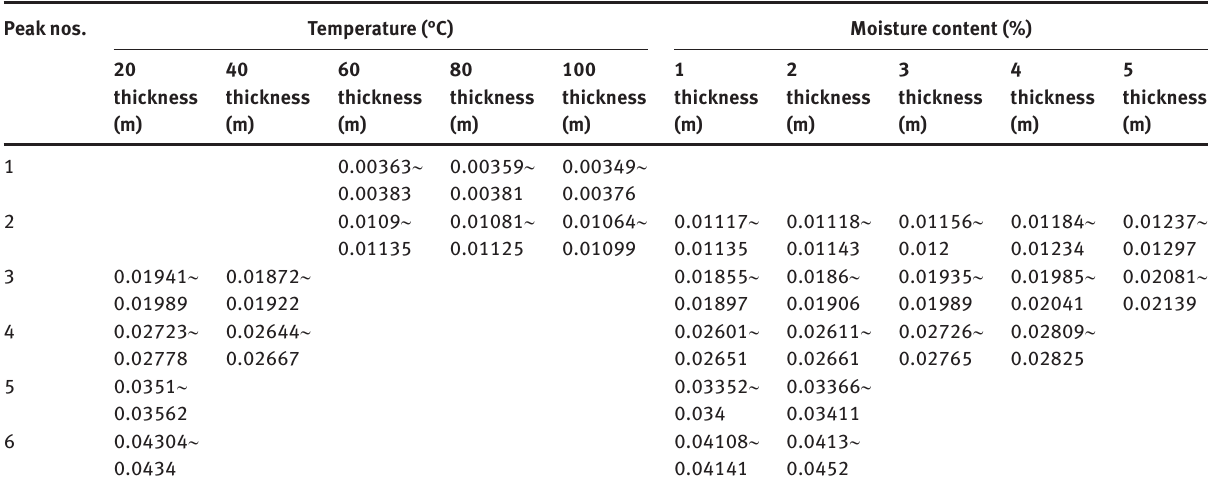
Table 2: The thickness ranges of the RL values less than –20 dB over the moisture content of 1% to 5% at 20 °C and petroleum coke (10% moisture content) in the temperature range of 20 °C to 100 °C at 2.45 GHz. Peak